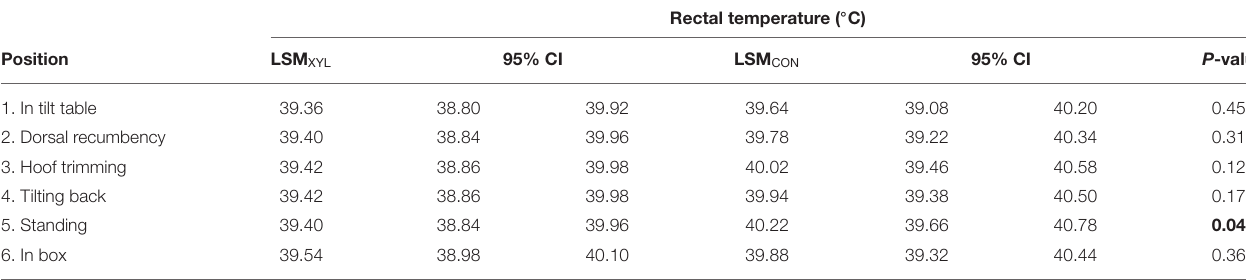
TABLE 4 | Treatment (CON, XYL) comparison at different positions for the rectal temperature.